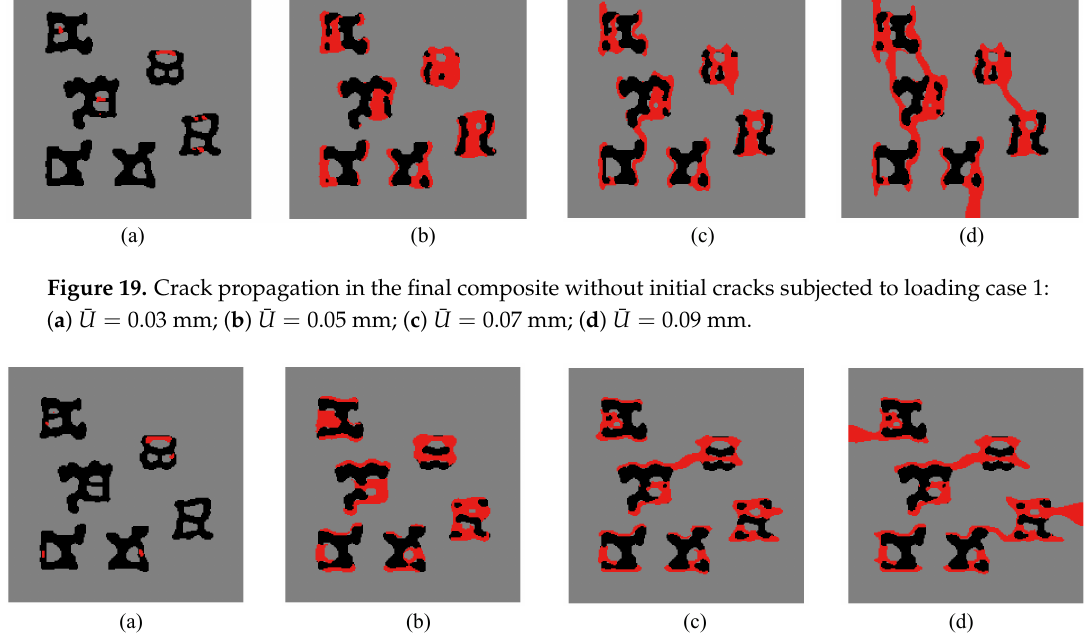
Figure 20. Crack propagation in the final composite without initial cracks subjected to loading case 2: